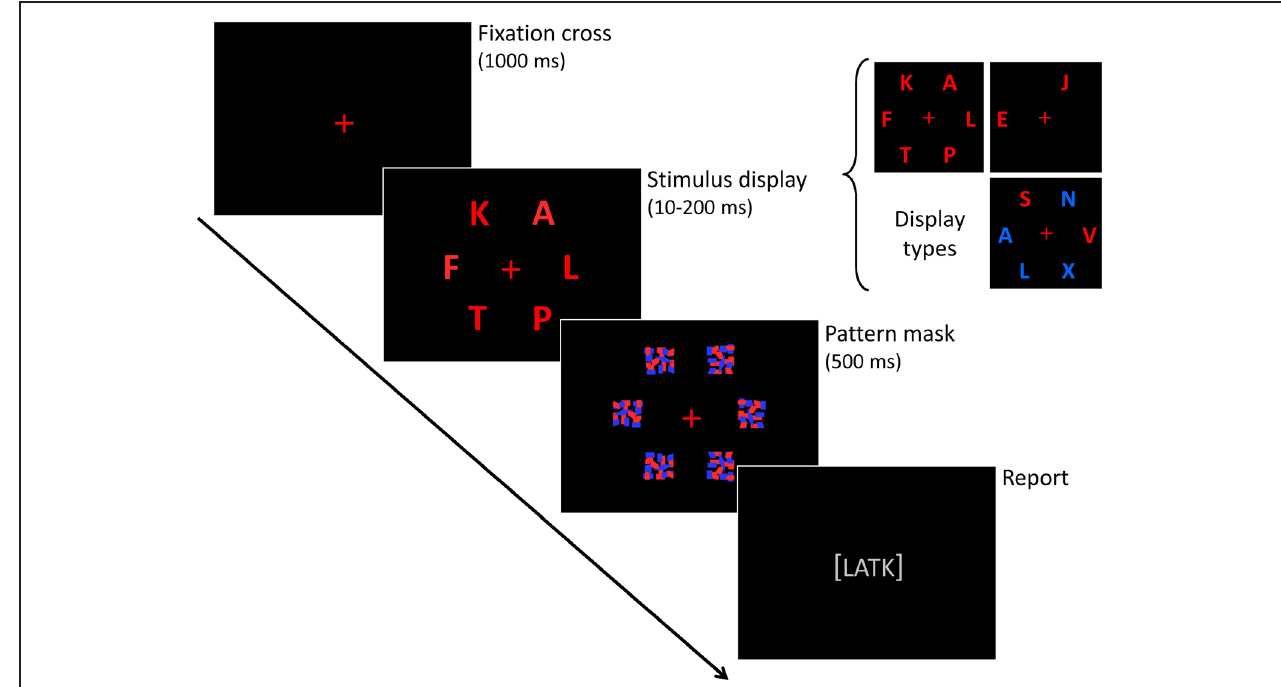
FIGURE 3 | The CombiTVA paradigm devised by Vangkilde et al. (2011). The outline of a single trial is shown, together with the three trial